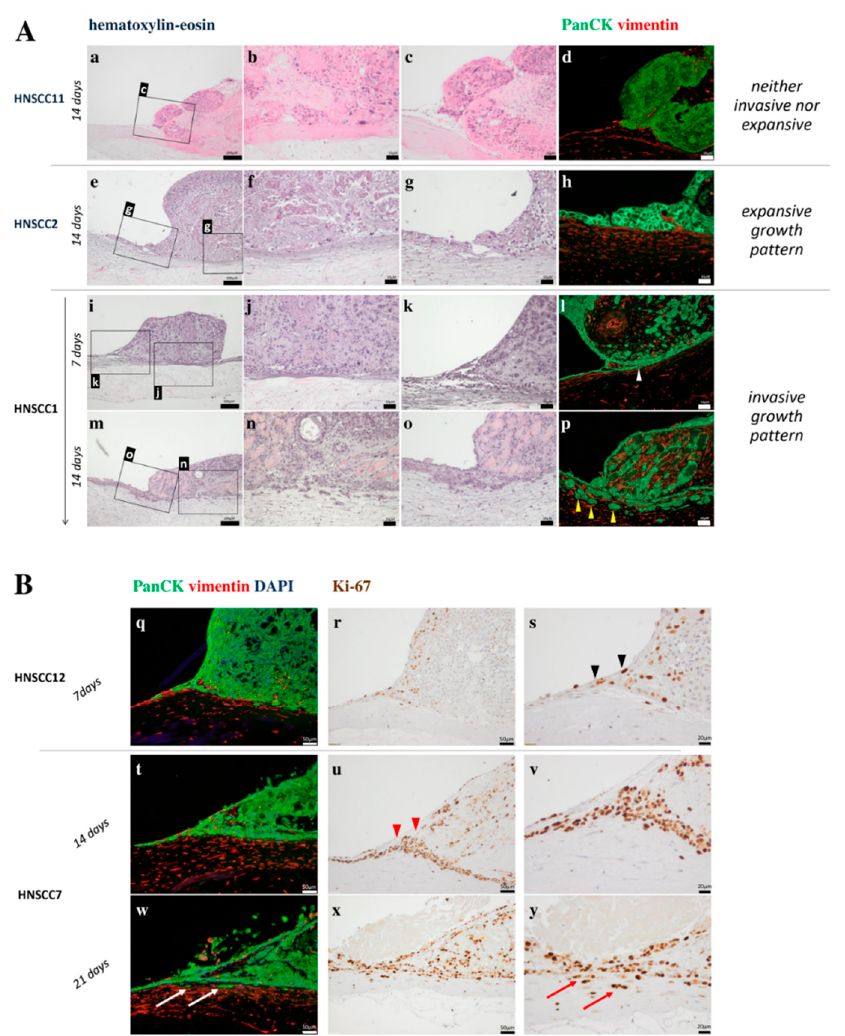
Figure4. VisualizationofdistincttumorgrowthpatternsbyH / Estaining, IHC,andIF.( A )Representative pictures of three di ff erent non-HPV-driven 3D-OTCs; culture duration and staining with H / E and IF as indicated in order to visualize growth patterns of the individual sample. HNSCC11 does not show migration or invasion. Tumor cells of HNSCC2 migrate horizontally on top of the dermal equivalent. HNSCC1 presents expansively growing tumor cells on top as well as few detached clusters of tumor cells in the DE on day 7 (i–l; white arrowhead), which impose in larger size and number on day 14 (m–p; yellow arrowheads). Scale Bar: 200 µ m (a,e,I,m), 50 µ m(b–d,f–h,j–l,n–p). ( B ) IF and IHC with indicated antibodies of two 3D-OTCs at different timepoints. HNSCC12, classified as